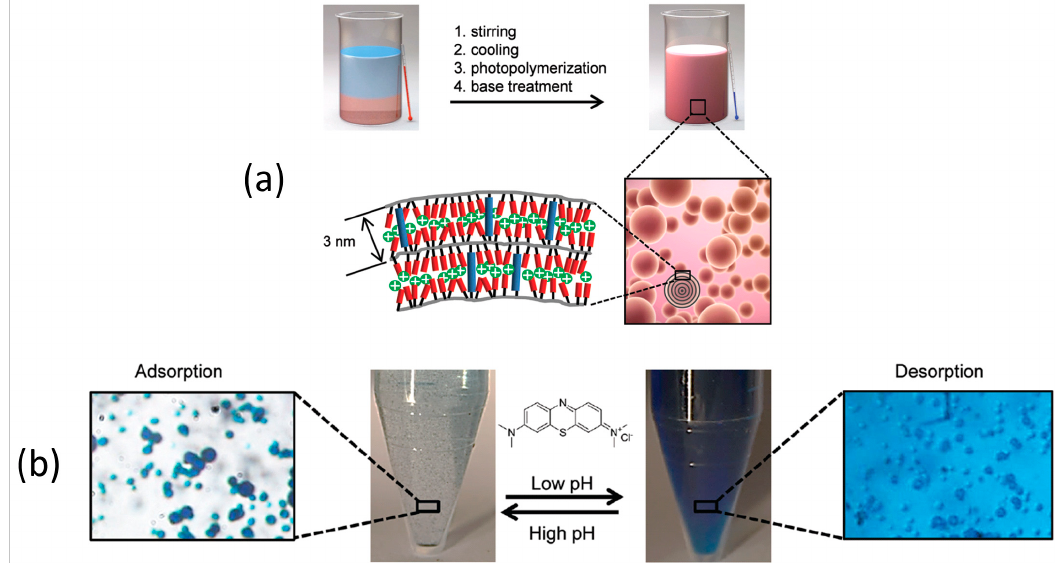
Figure 9. Nanoporous particles as adsorbents. ( a ) Illustration of polymer particle preparation from a polymerisable smectic liquid crystal; ( b ) Adsorption/desorption of methylene blue by the nanoporous particles. Adapted from [76]. Copyright 2016 The Royal Society of Chemistry (RSC).